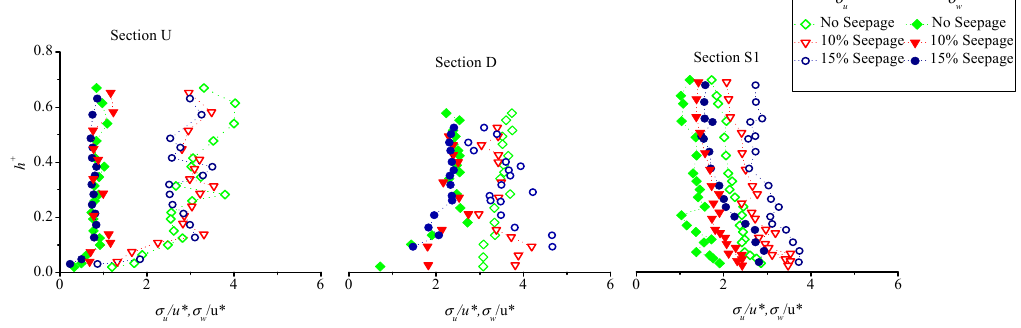
Figure 2. Non-dimensional distributions of turbulence intensities.